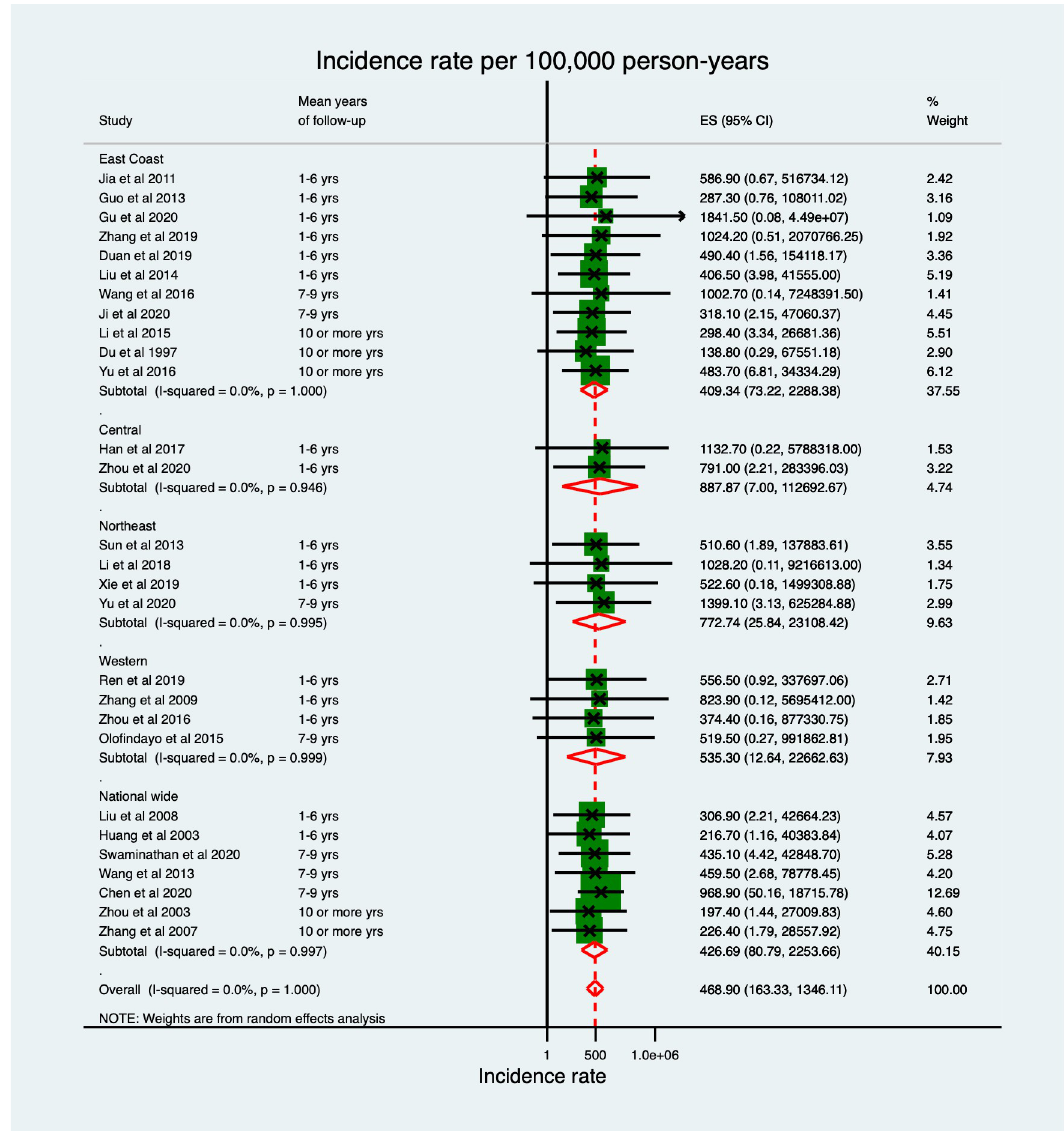
Fig 2. Total stroke incidence rate per 100,000